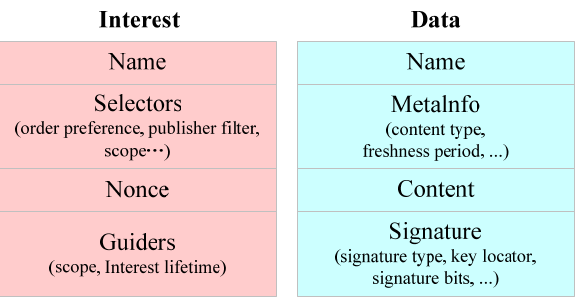
Figure 9. Packet